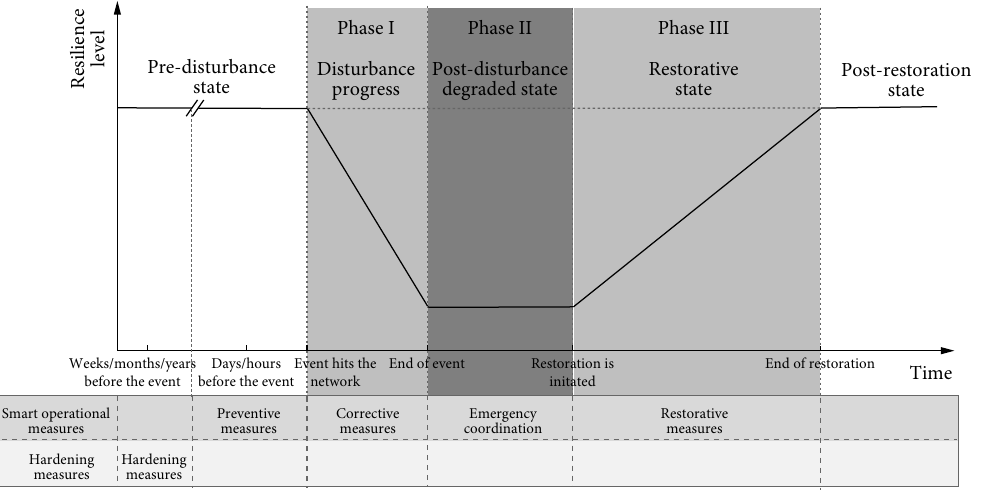
Fig. 1 Resilience trapezoid associated to a HILP event [15] .